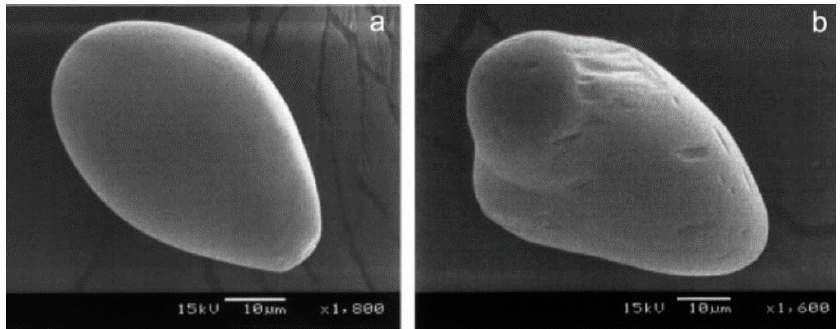
Figure 3. Scanning electron micrograph of potato starch granules ( a ) and, Freeze-dried potato starch granules ( b ), Source: Apinan et al. [63].